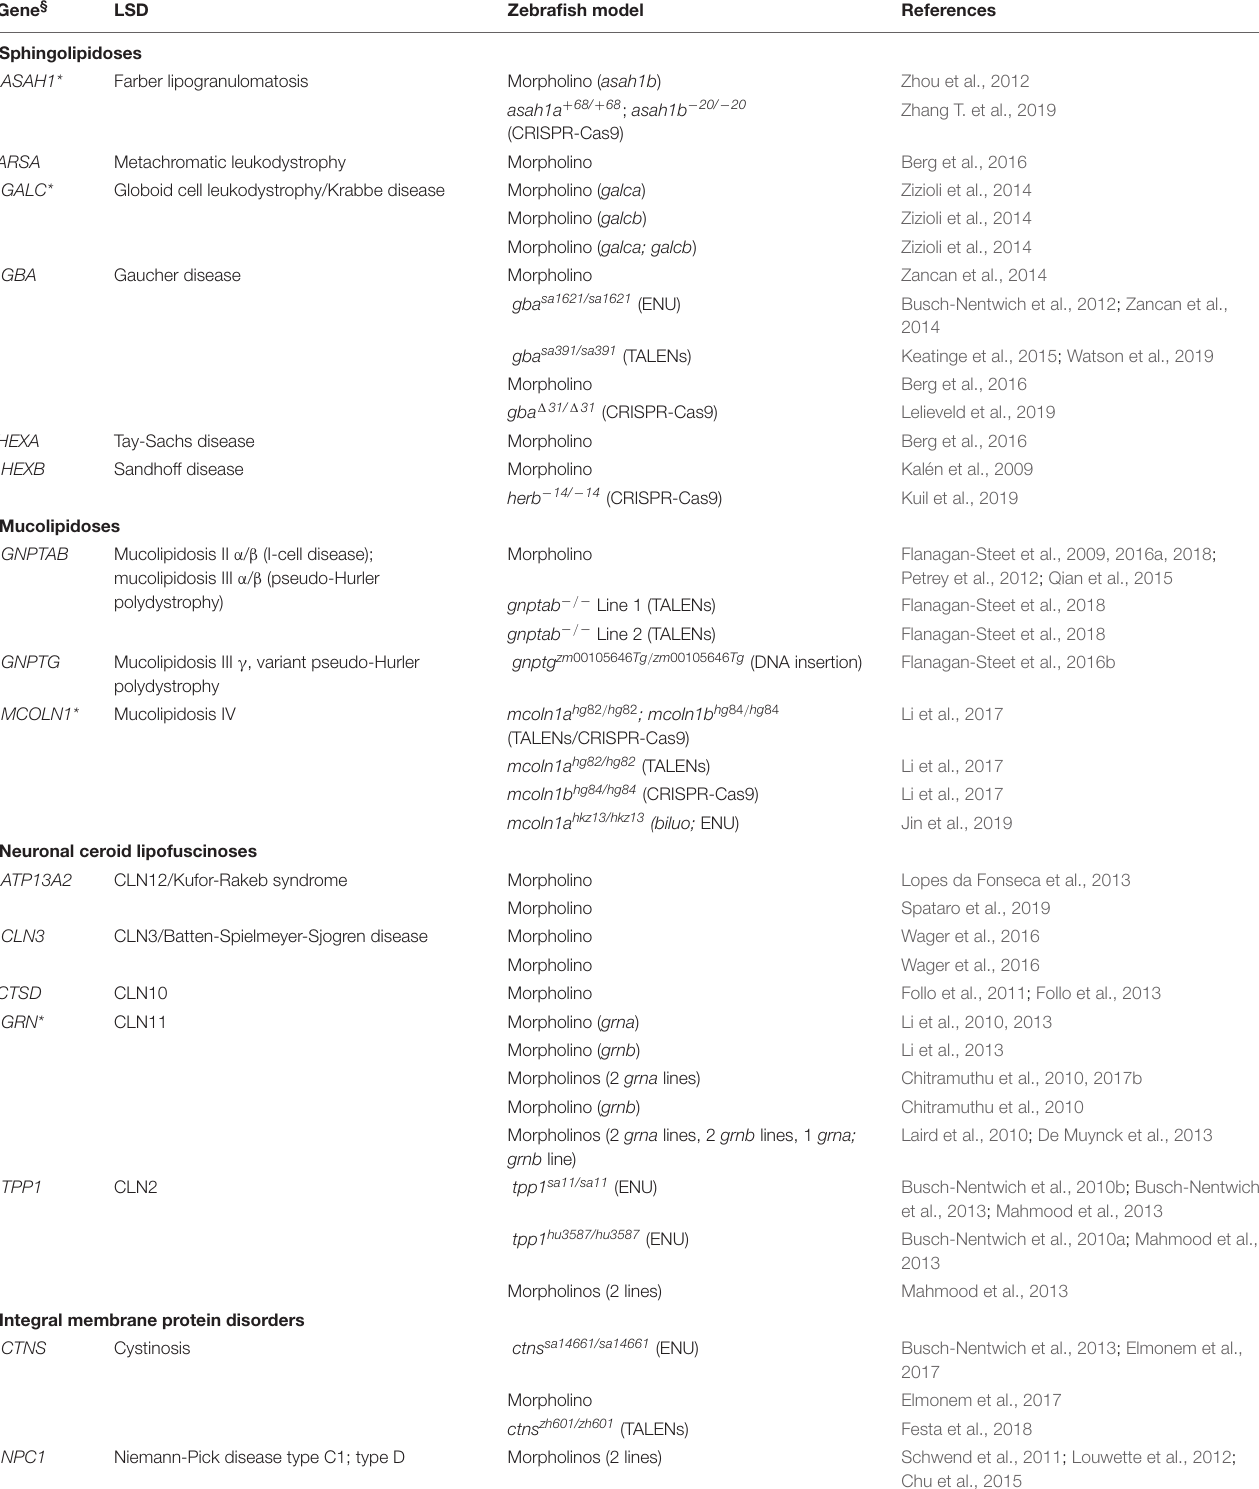
TABLE 2 | List of published zebrafish LSD